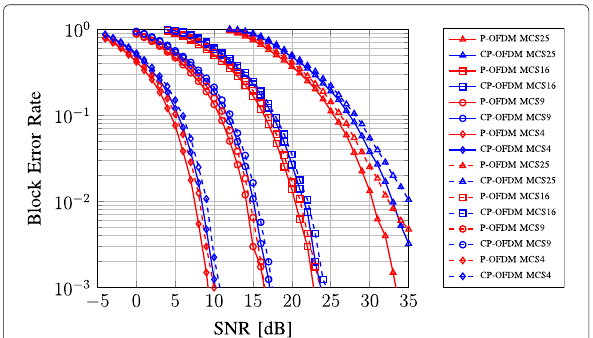
K = 4. Detailed simulation assumptions are given in Table 9. The energy of the symbols are assumed to be nor- malized to one. The simulation results shown in Figs. 18 and 19 confirm the advantages of pulse-shaped OFDM gains of 3 ∼ 5